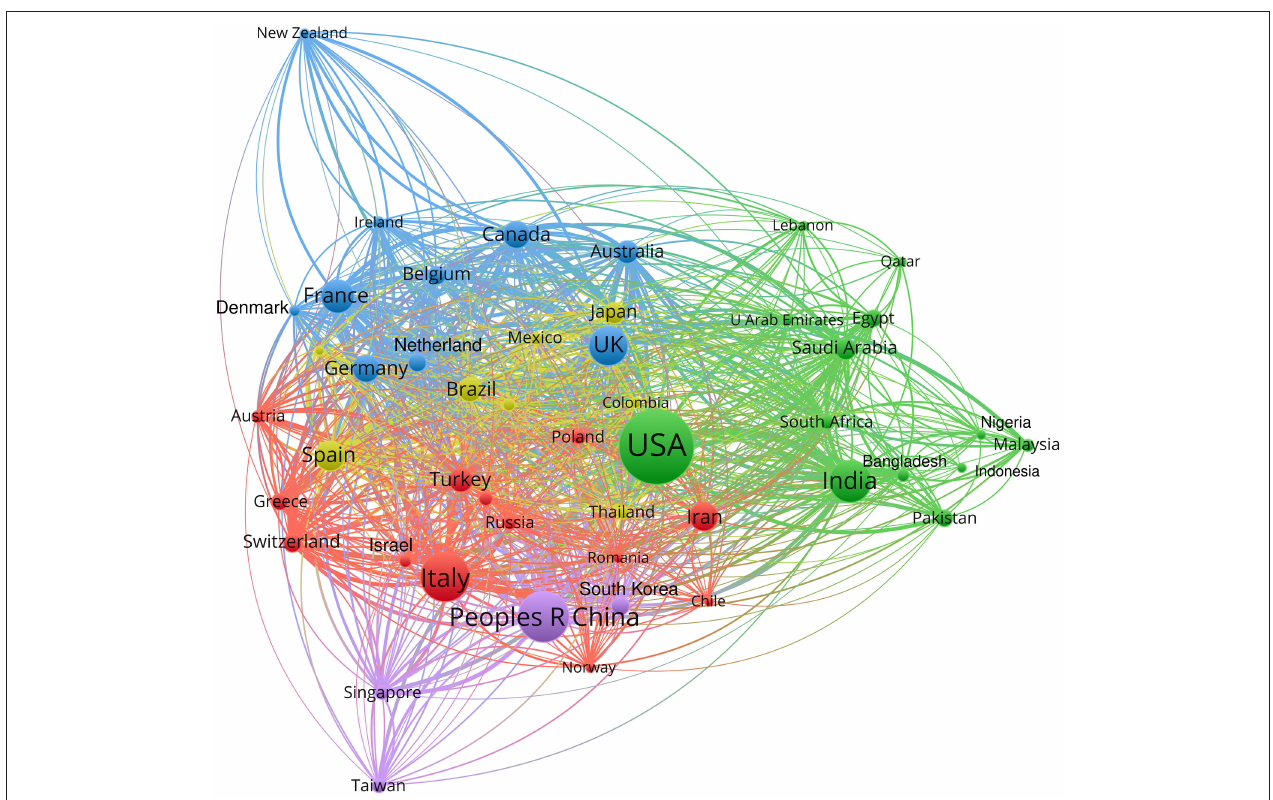
FIGURE 3 | Bibliometric network of production by